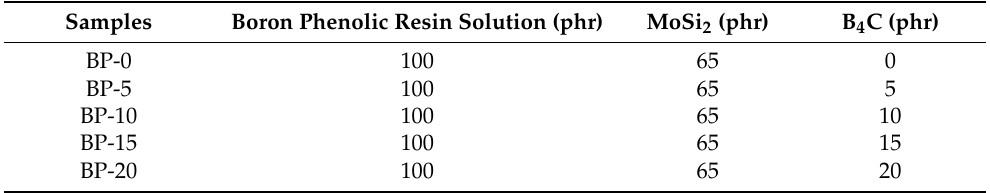
Table 1. Formula of ceramizable boron phenolic resin